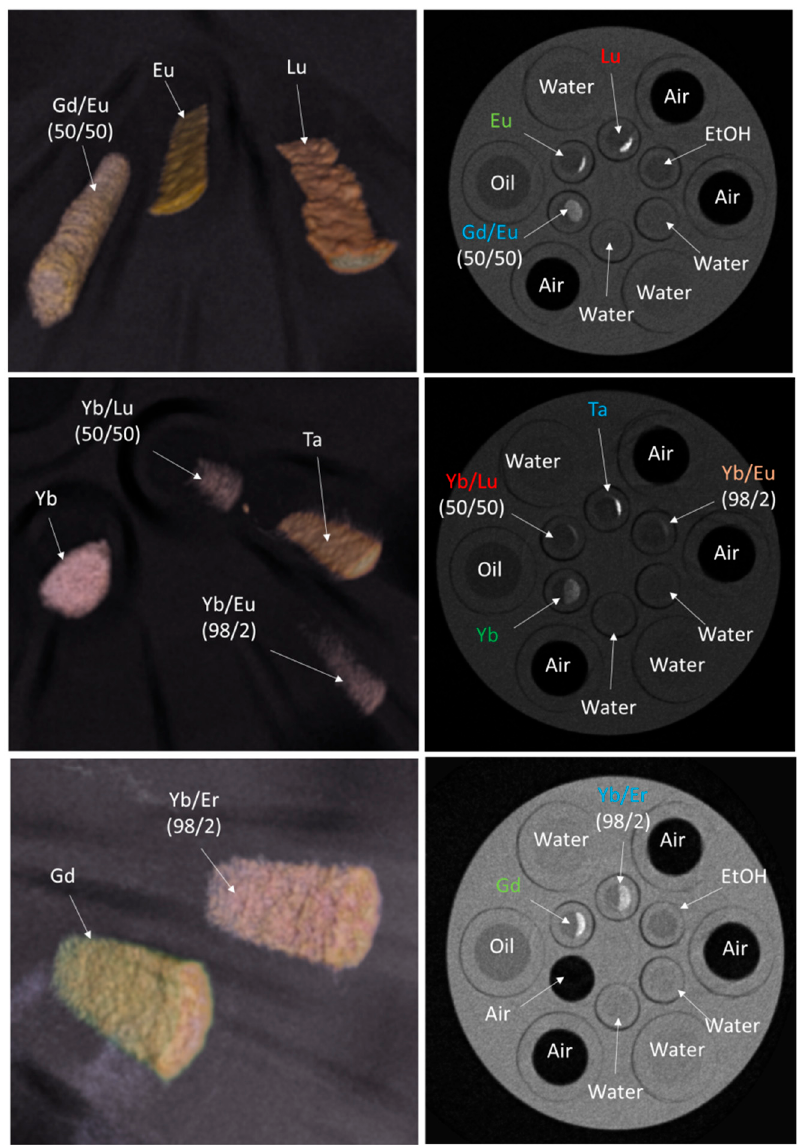
Figure 1. Micro-CT images of different OA-stabilized nanophosphors (NPhs) at 30 mg/mL in 30% ethanol, including either 100% metals (Eu, Lu, Yb, Gd, Ta) or combination of metal dopants [Gd/Eu (50:50), Gd/Lu (50:50), Yb/Eu (98:2), Yb/Er (98:2), and Yb/Lu (50:50)]. Unlike the reported fluorescence upconversion trend of doped La-NPhs, pure metals showed higher CT contrast.